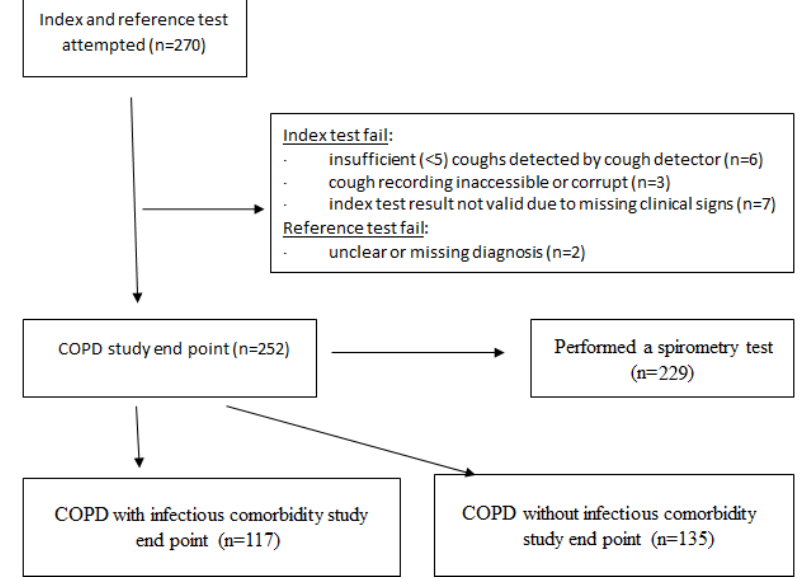
Figure 1. The flow of participants through the study. COPD: chronic pulmonary obstructive disease.